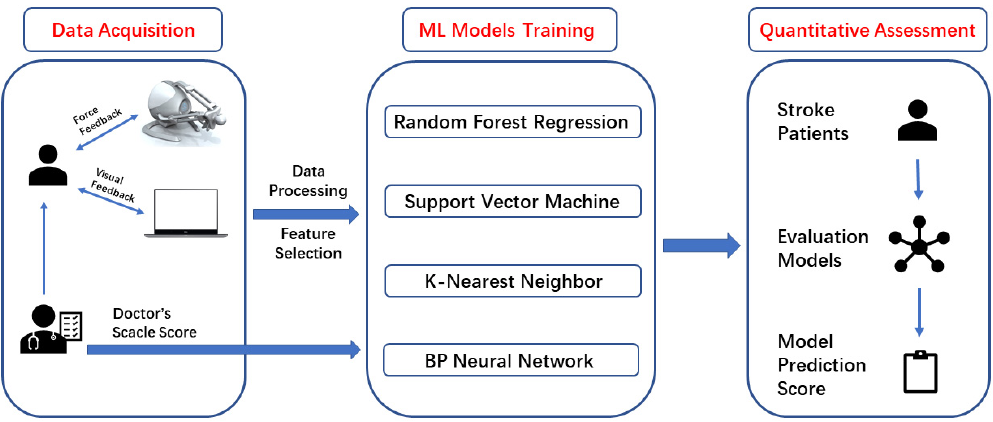
Figure 1. System framework for quantitative evaluation of wrist motor function based on force feed- feedback and machine learning back and machine learning algorithms.